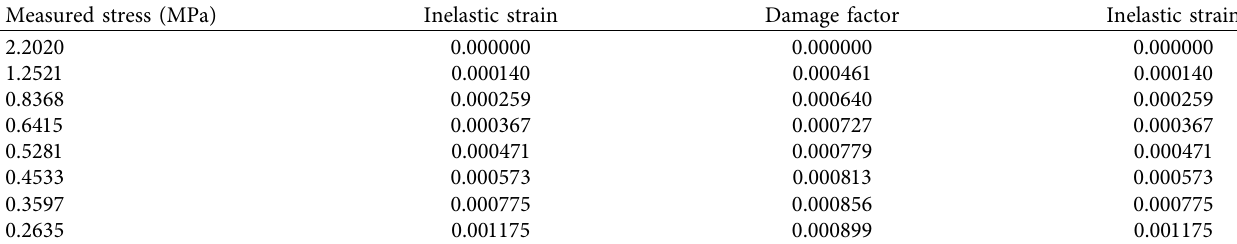
Table 2: Plastic constitutive model of concrete under tensile damage under 500,000 cycles of fatigue load.